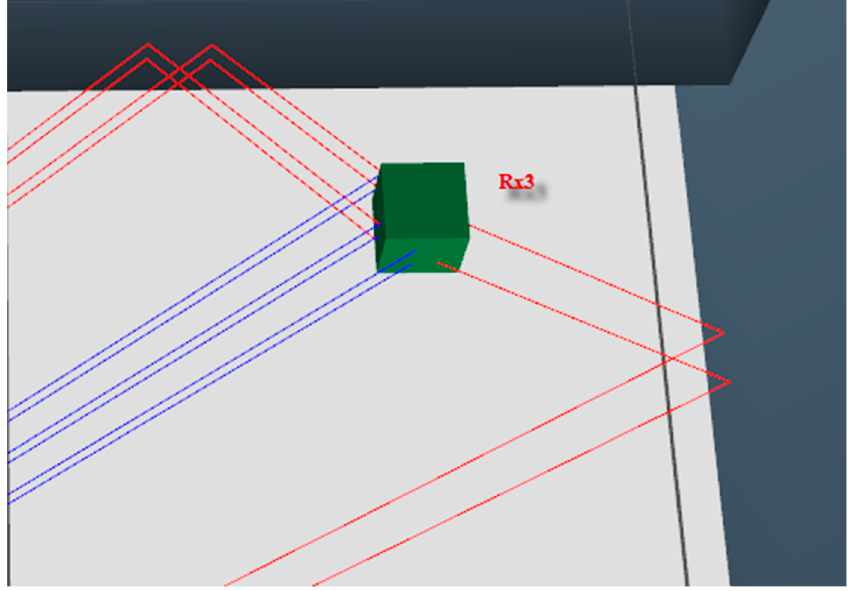
Figure 5. Zoom-in view of Rx3 receiver.